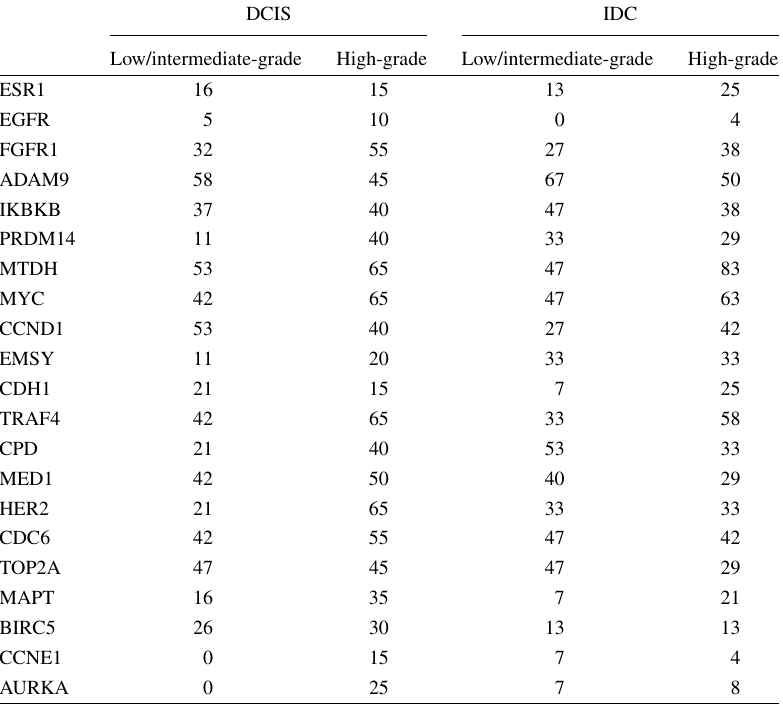
Frequencies of alterations (gain, amplification and loss) in low/intermediate-grade and high-grade DCIS and adjacent IDC present in 39 breast tumor samples